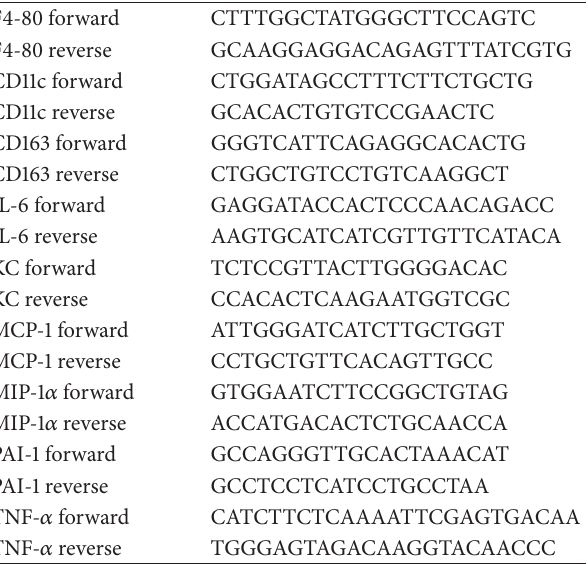
Table 1: Real-time qPCR